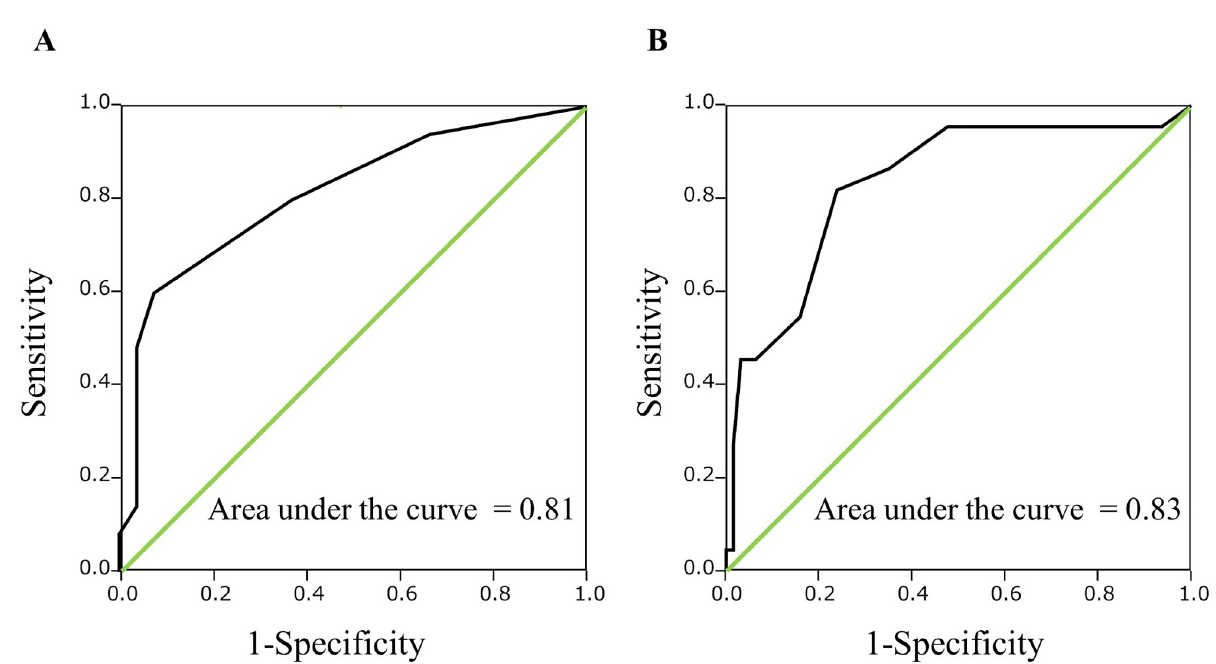
Fig 5. (A) ROC curve of CTC count for discrimination between HCC patients and non-HCC patients. (B) ROC curve of CTC count for prediction of microscopic portal vein invasion in HCC patients.